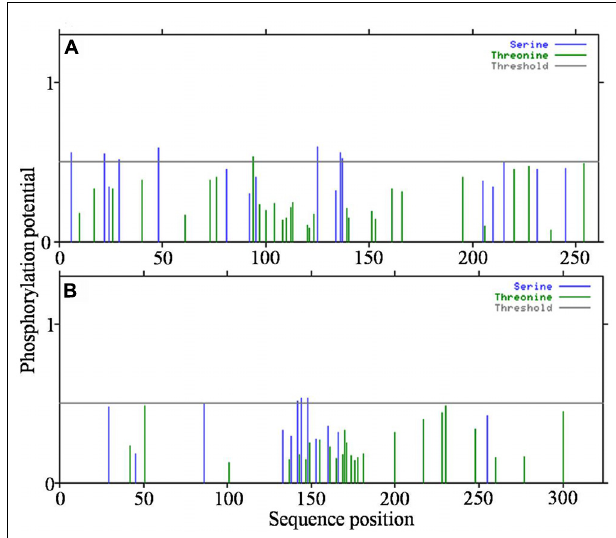
FIGURE 6 | Detection of post-translational modification sites in hypothetical proteins. (A) -all3797, and (B) -all4050 (obtained from http://www.cbs.dtu.dk/services/NetPhosBac-1.0/).